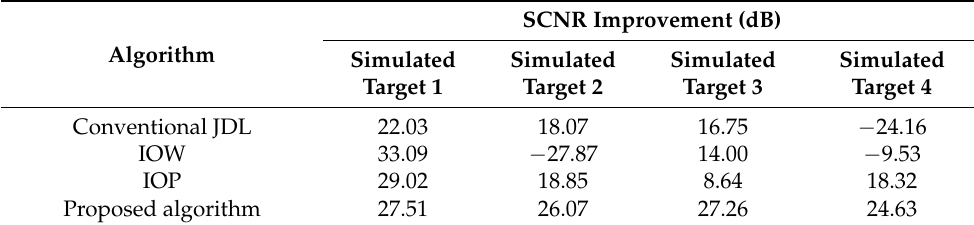
Table 3. Signal-to-clutter-plus-noise ratio (SCNR)